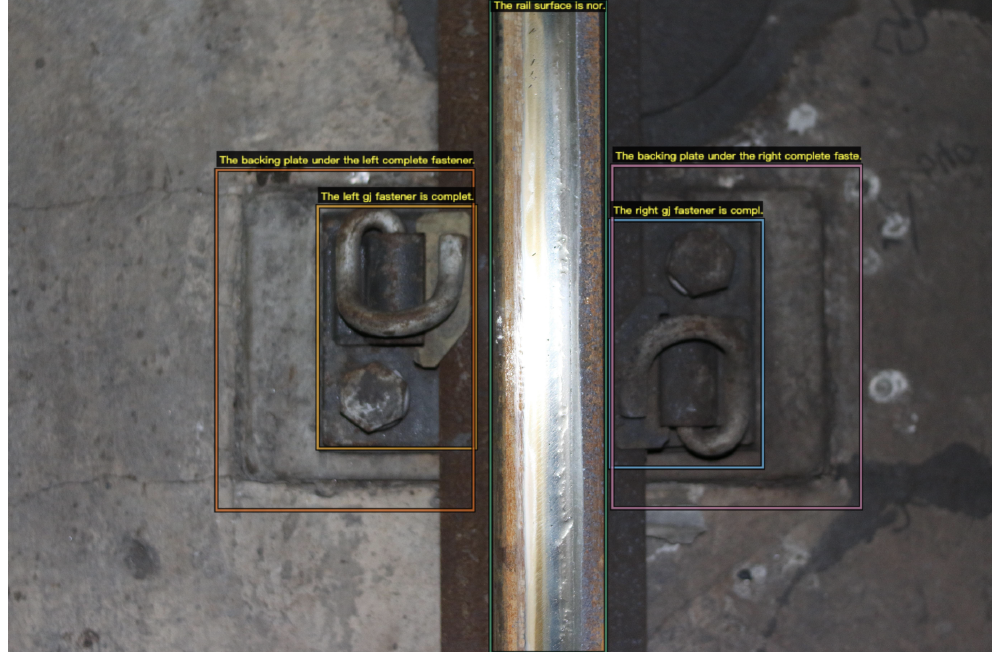
Figure 7. Example of manual labeling using the VGG image annotator with image regions and captions.